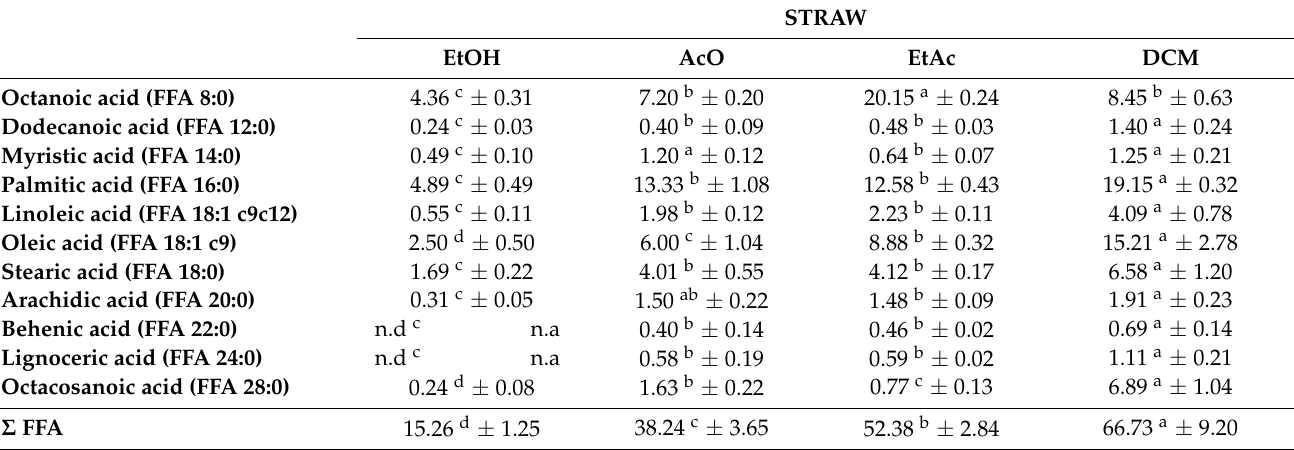
Table 3. Profile (g/kg) in free fatty acids, hydrocarbons, fatty alcohols, sterols, fatty aldehydes, and terpenes of different sugarcane straw